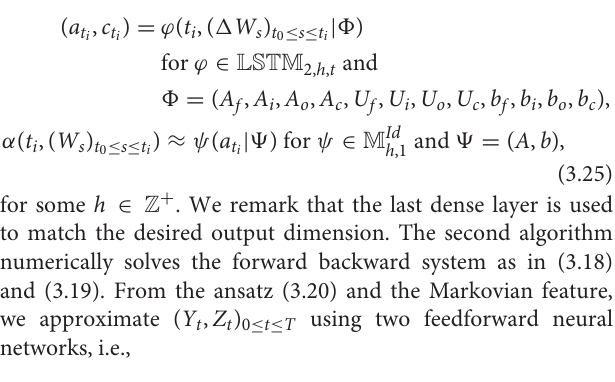
FIGURE 2 | On the left, we compare the sample mean of optimal trajectories of ( X t of optimal control ( α t ) t between approach 1 and approach i 0 ≤ t i ≤ t N